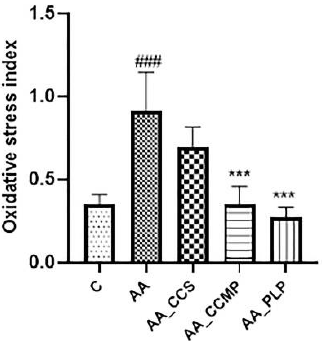
Figure 3. Oxidative stress index. Data are expressed as the mean ± SD for each group. ### p < 0.0001 indicates a significant difference in comparison with the control group; *** p < 0.0001 indicates a significant difference in comparison with the AA group. Abbreviations: C, normal control group; AA, acetic acid group; AA_CCS, curcumin group; AA_CCMP, Col-CUR-MPs group; and AA_PLP, prednisolone group. The bars represent mean values with standard deviations.